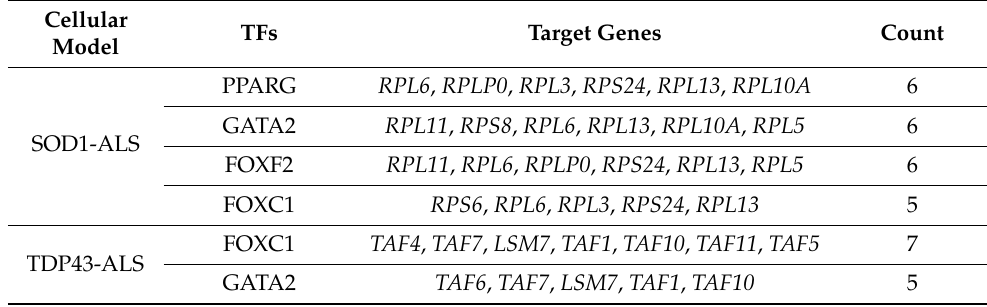
Table 2. Transcription factors (TFs) of hub